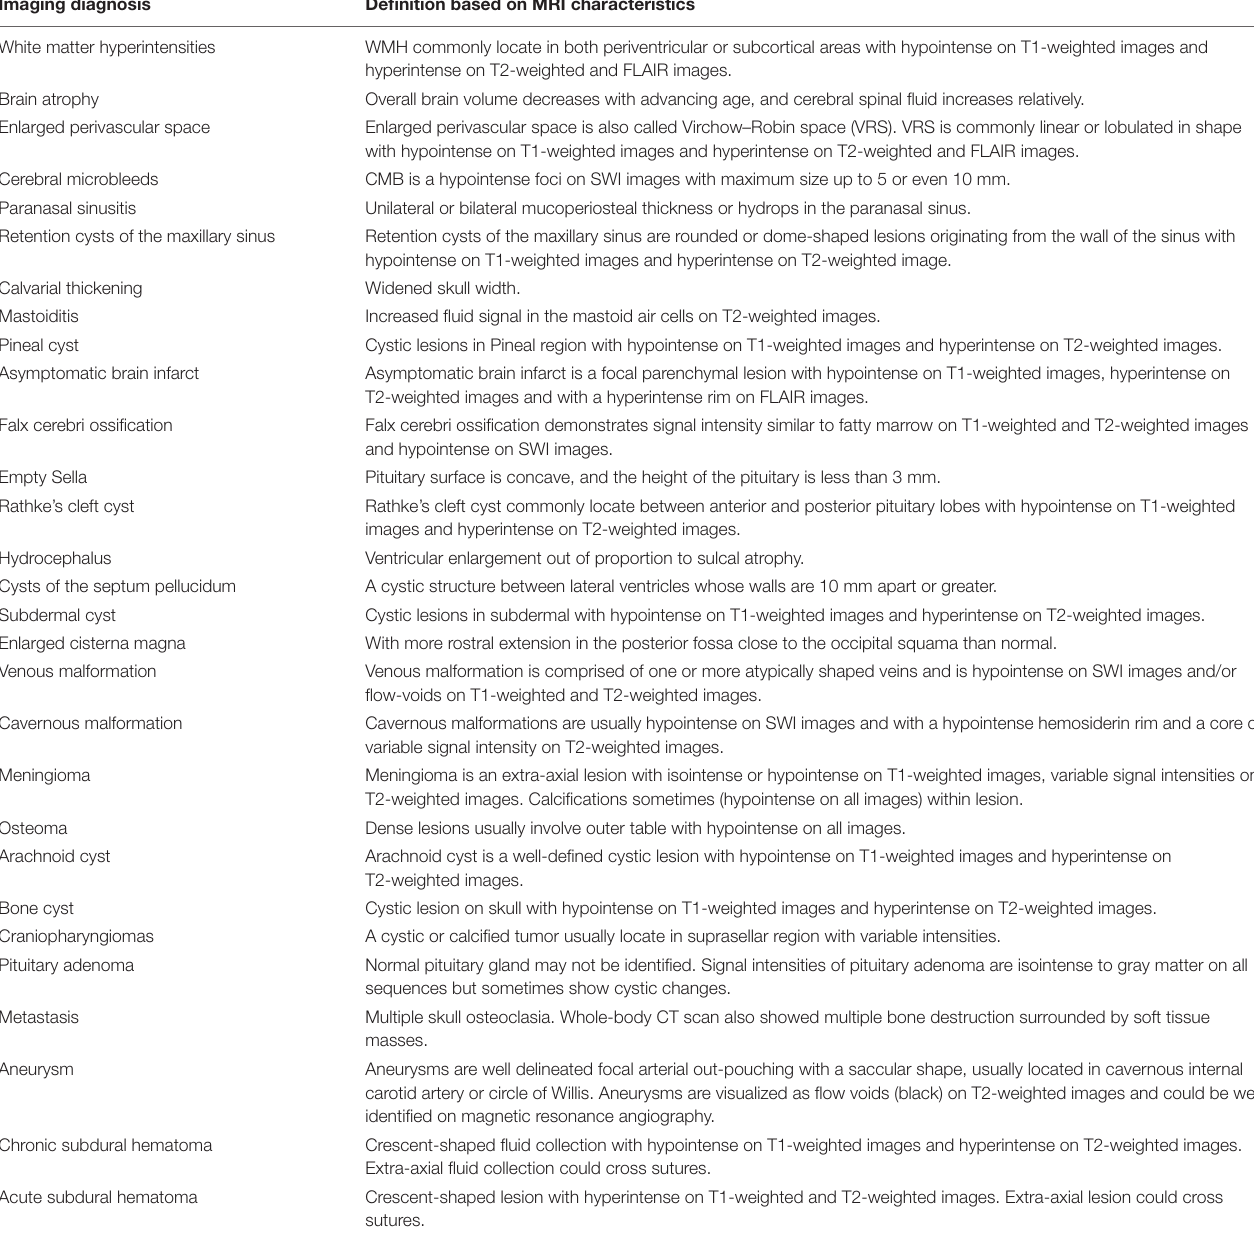
TABLE 2 | Definitions of the incidental